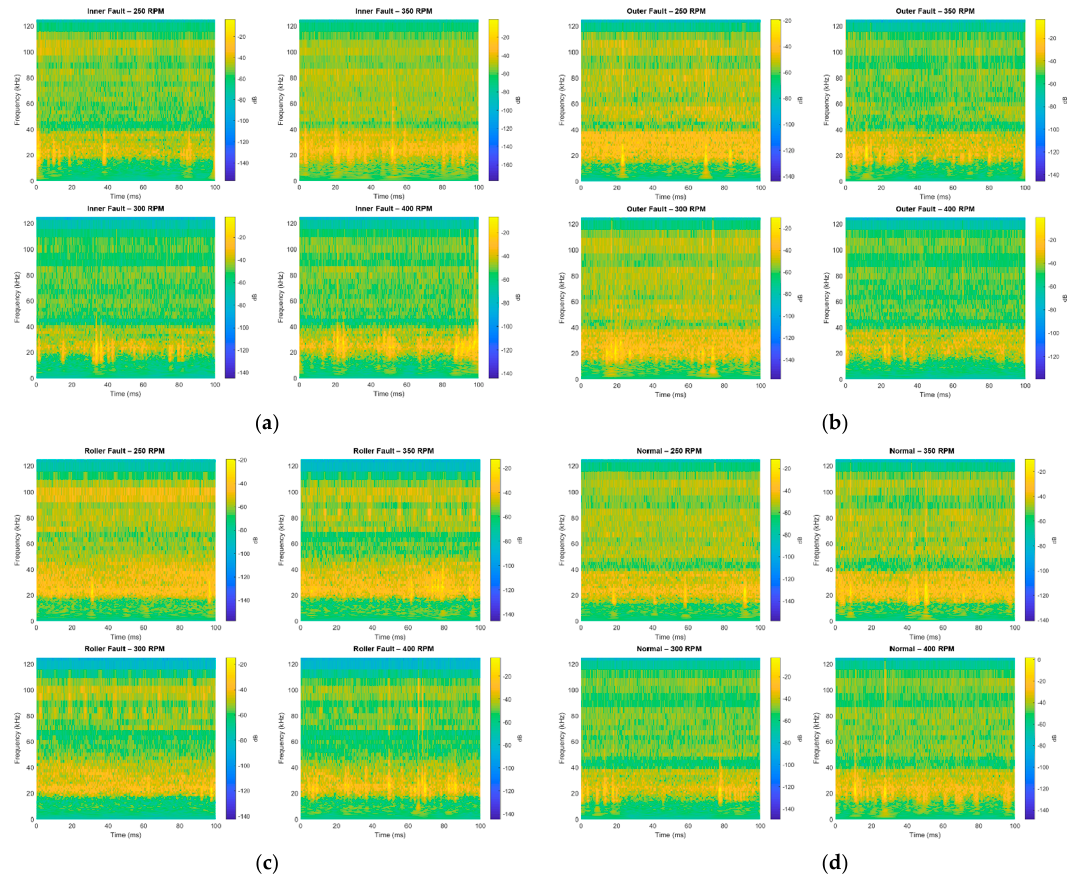
Figure 2. Spectrograms created by constant-Q transform for the acoustic emission (AE) signals from the bearings at various states: ( a ) inner race defect; ( b ) outer race defect; ( c ) roller defect; ( d ) normal state.